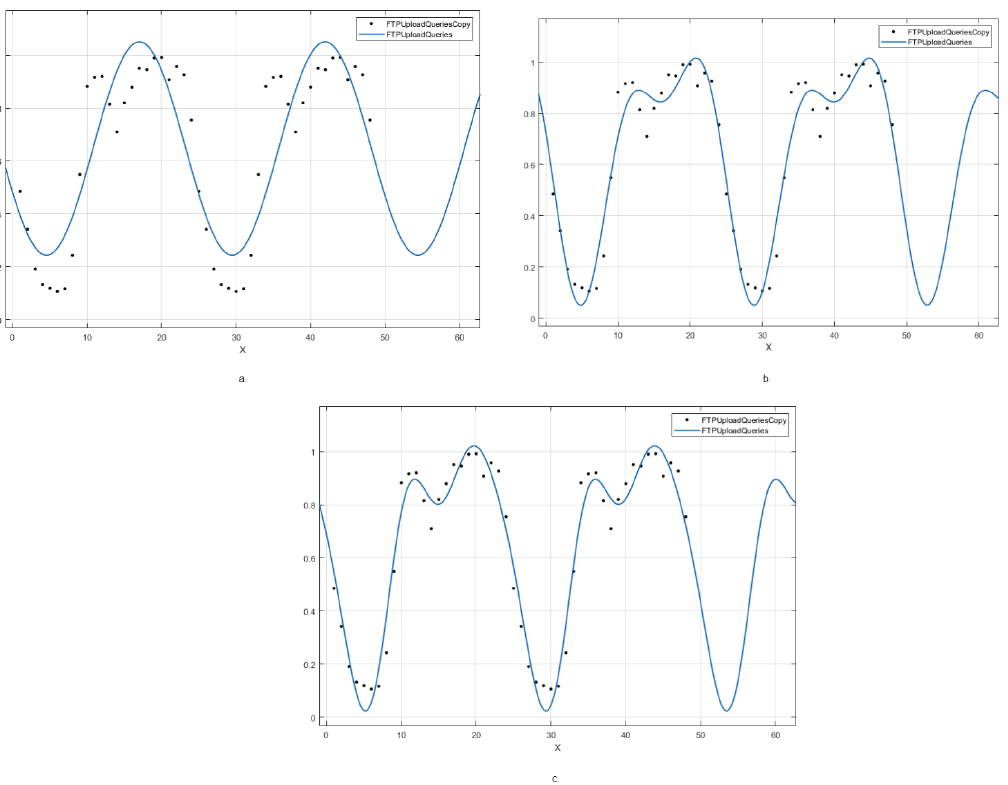
Figure 3. ( a ) Graph of the approximation function a ( t ) for upward flow with one condition; ( b ) Graph of the approximation function a ( t ) for upward flow with two conditions; ( c ) Graph of the approxima- tion function a ( t ) for upward flow with three